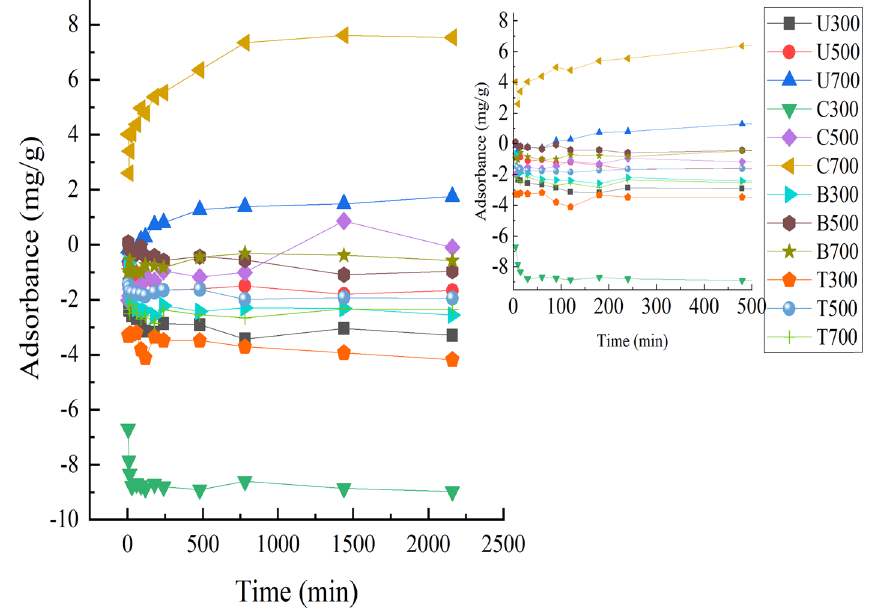
Figure 1: Adsorption kinetics adsorption on 12 kinds of biochar.